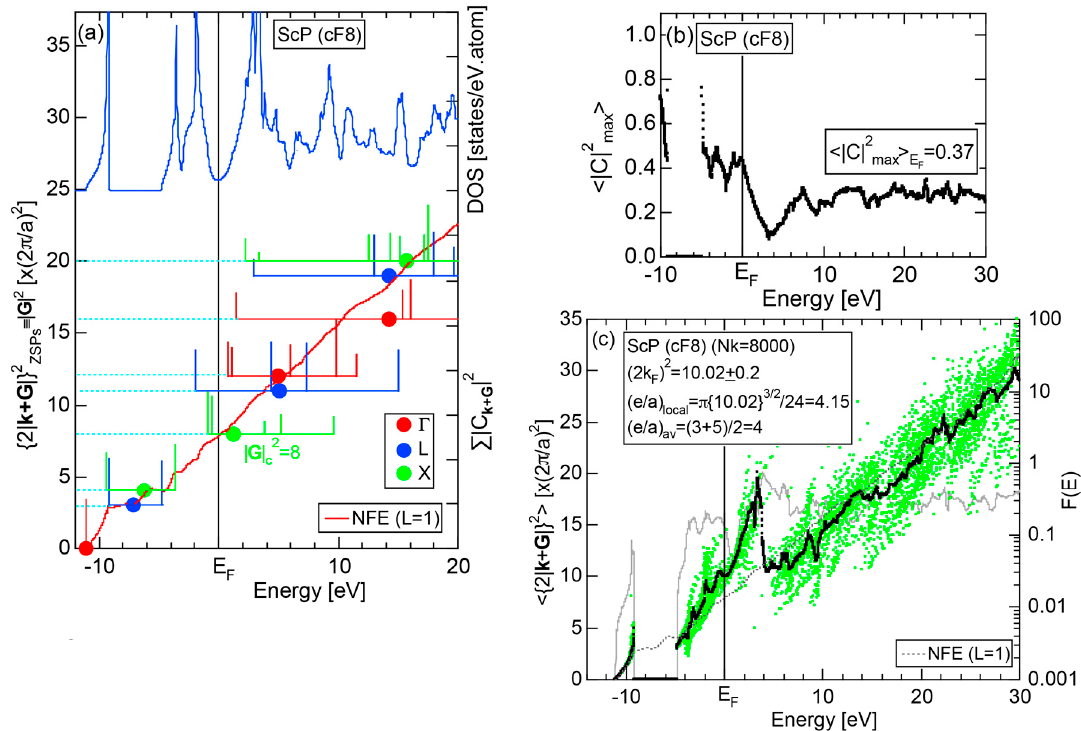
Figure 71. ( a ) FLAPW-Fourier spectra at symmetry points Γ , L, and X of the fcc Brillouin zone along with the total DOS, ( b ) C and ( c ) Hume-Rothery plot for ScP (cF8). See captions of Figure 34d for symbols in (c) [11,12].